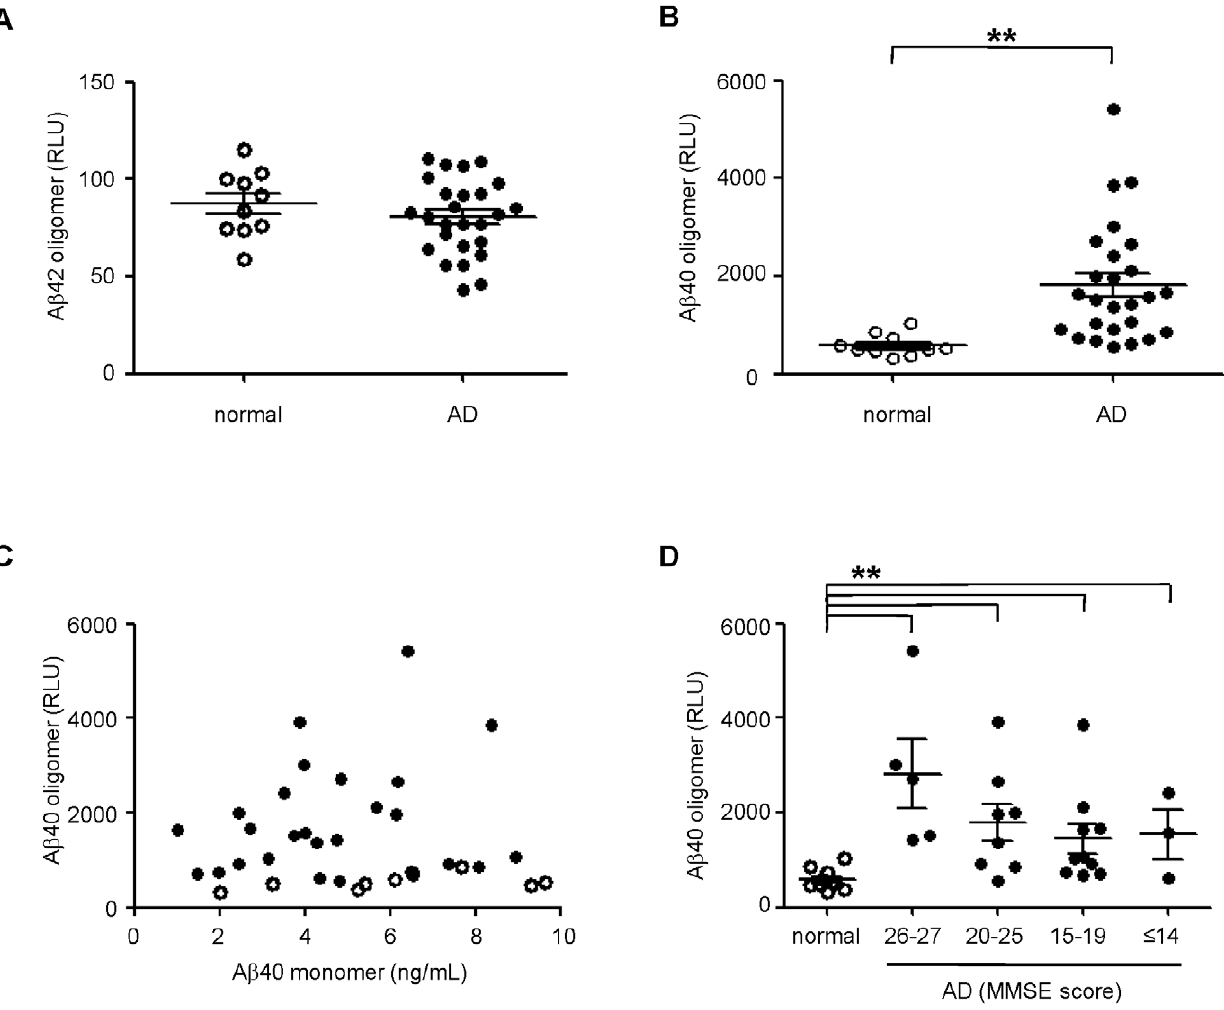
Figure 4. MPA detection of A b 40 oligomers from AD CSF. Normal (open circles) and AD (closed circles) CSF were analyzed by the MPA. Oligomers containing A b 42 (A) and A b 40 (B) were captured by ASR1 beads followed by detection using a multiplex immunoassay. Significant differences between normal and AD population were calculated by t-test (A b 42, p =0.31; A b 40, ** p , 0.01). C. Lack of correlation between MPA- detected A b 40 signal and the concentration of A b 40 monomers in AD CSF (R 2 =0.037). D. The distribution of A b 40 oligomers by disease severity was examined by categorization of AD patients according to MMSE scores (** p , 0.01 between normal and all AD groups). The mean and standard error of the mean (SEM) are shown for all groups.